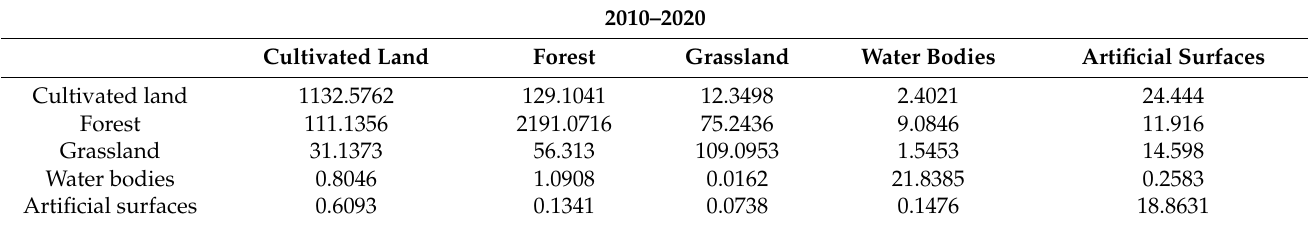
Table 2. Transition matrix of land-use types in Enshi City from 2010 to 2020 (km 2